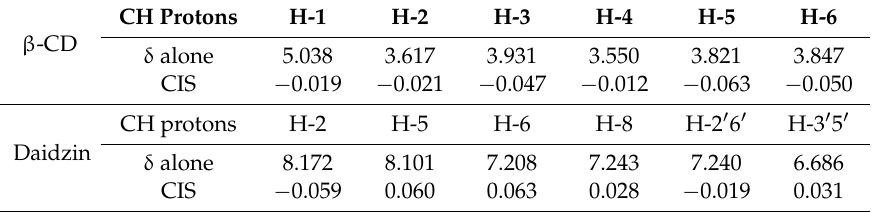
Table 2. 1 H-NMR Chemical shifts ( δ , ppm) for CH protons of β -CD alone, daidzin alone and their complexation induced shifts (CIS = δ complex ´ δ guest ) in D 2 O at 30 ˝